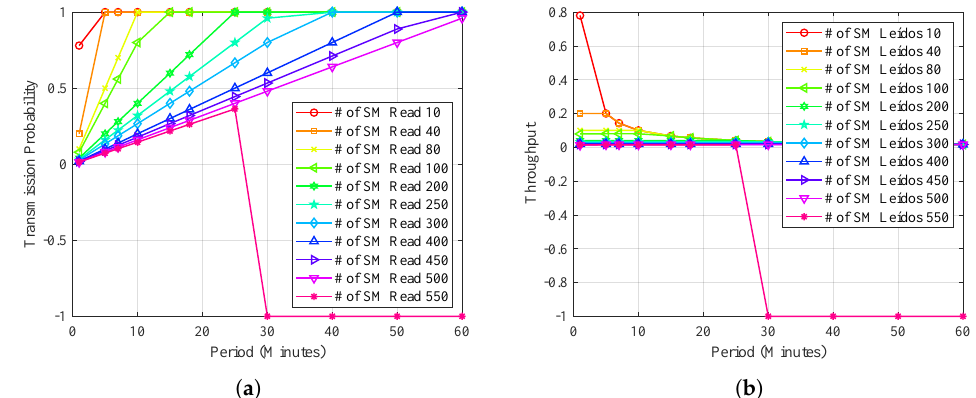
Figure 5. Behavior over time—channel assignment. ( a ) Transmission probability/period; ( b ) through-